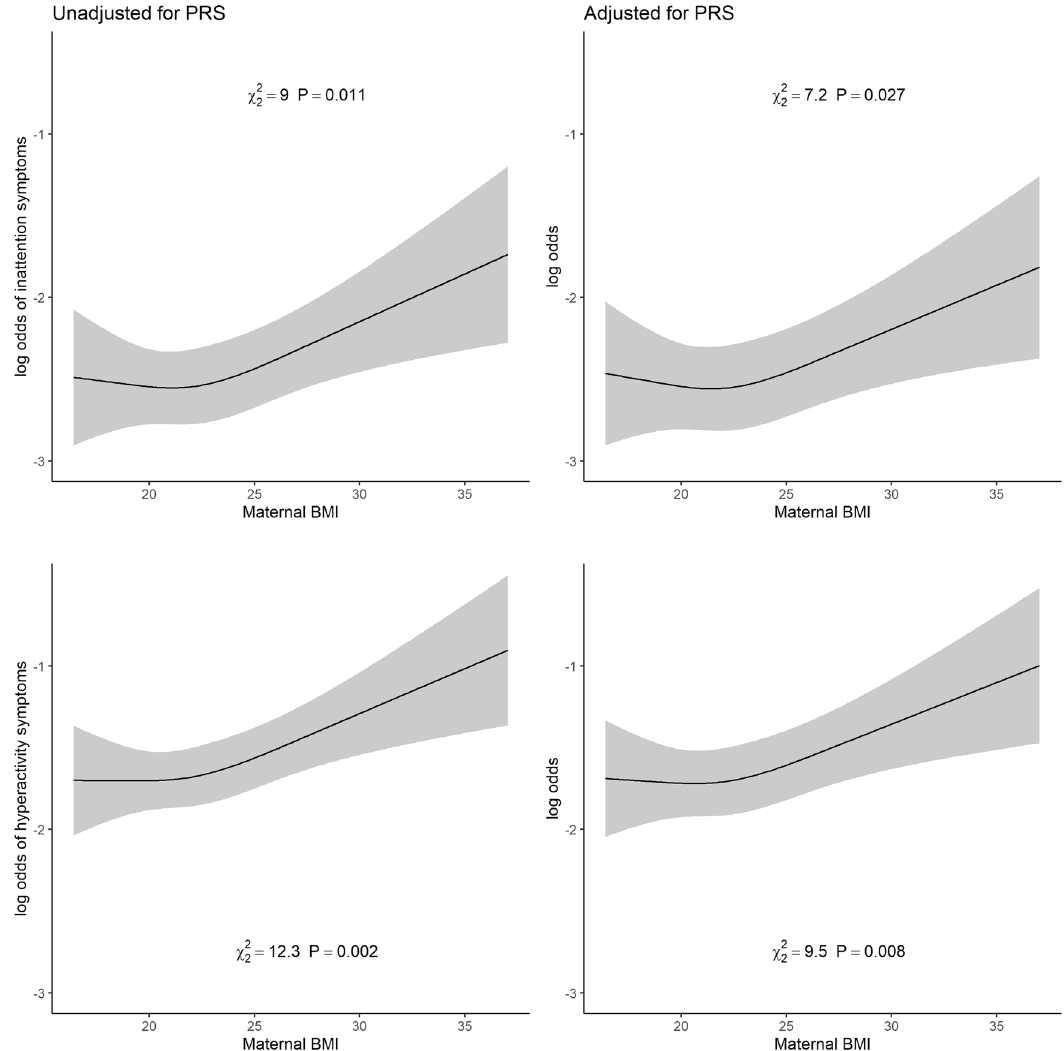
Fig. 4 Association between maternal pre-pregnancy BMI and the log-odds of increasing number of teacher-rated inattention (top panels) and hyperactivity (bottom panels) symptoms at eight years, adjusted for parity, maternal education, smoking during pregnancy, age at delivery and offspring sex. Left panels show the associations without an additional adjustment for PRS of ADHD and BMI, and right panels show the associations with the